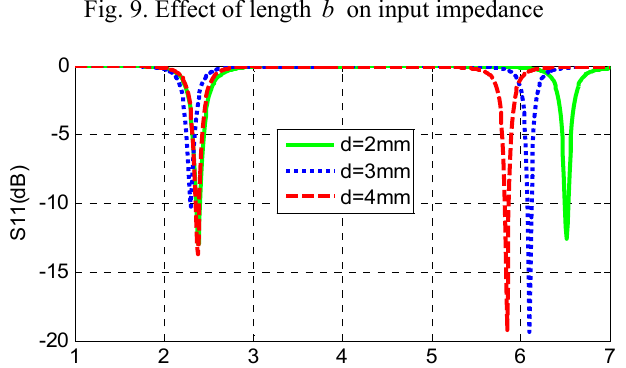
Fig. 5. Effect of length a on input impedance